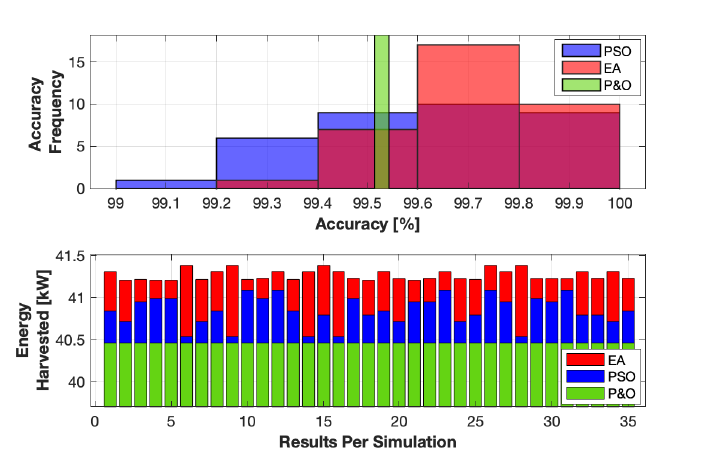
Figure 22. Accuracy of the tracked MPPs and energy harvested per simulation from the low power case study.